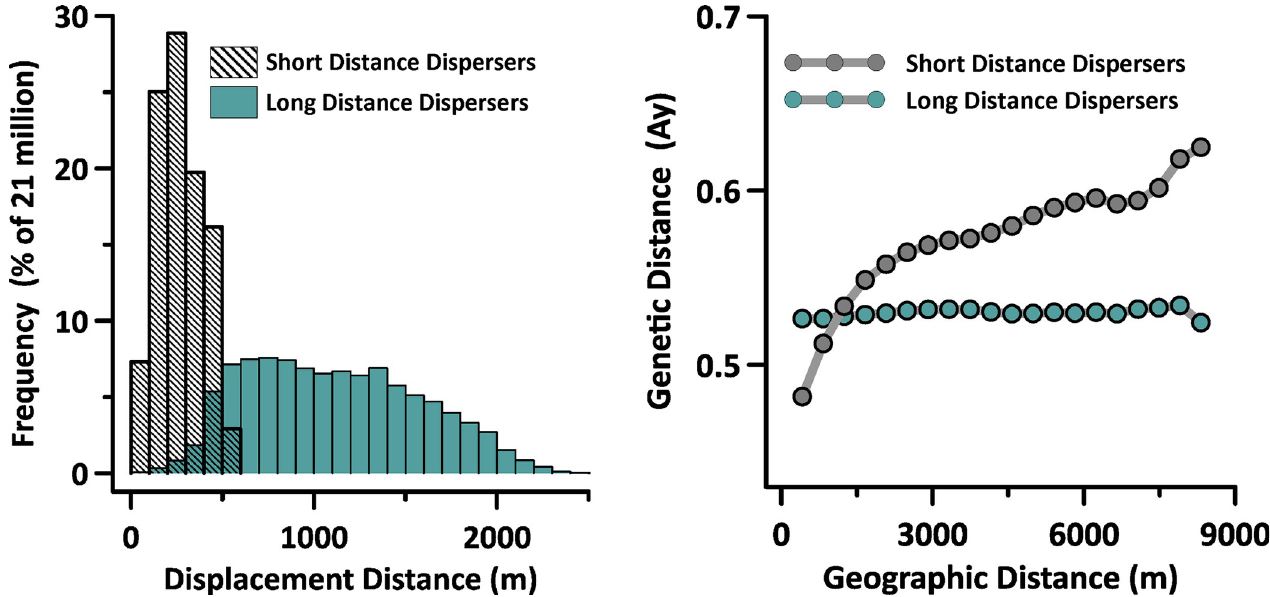
Fig 3. In a spatially-continuous landscape, the observed dispersal kernels reflected juvenile dispersal ability (left). Genetic IBD was evident when dispersal paths were short, but not when they became longer (right). These data were gathered at the end of the Continuous landscape epoch, after 115 generations of unobstructed movement.